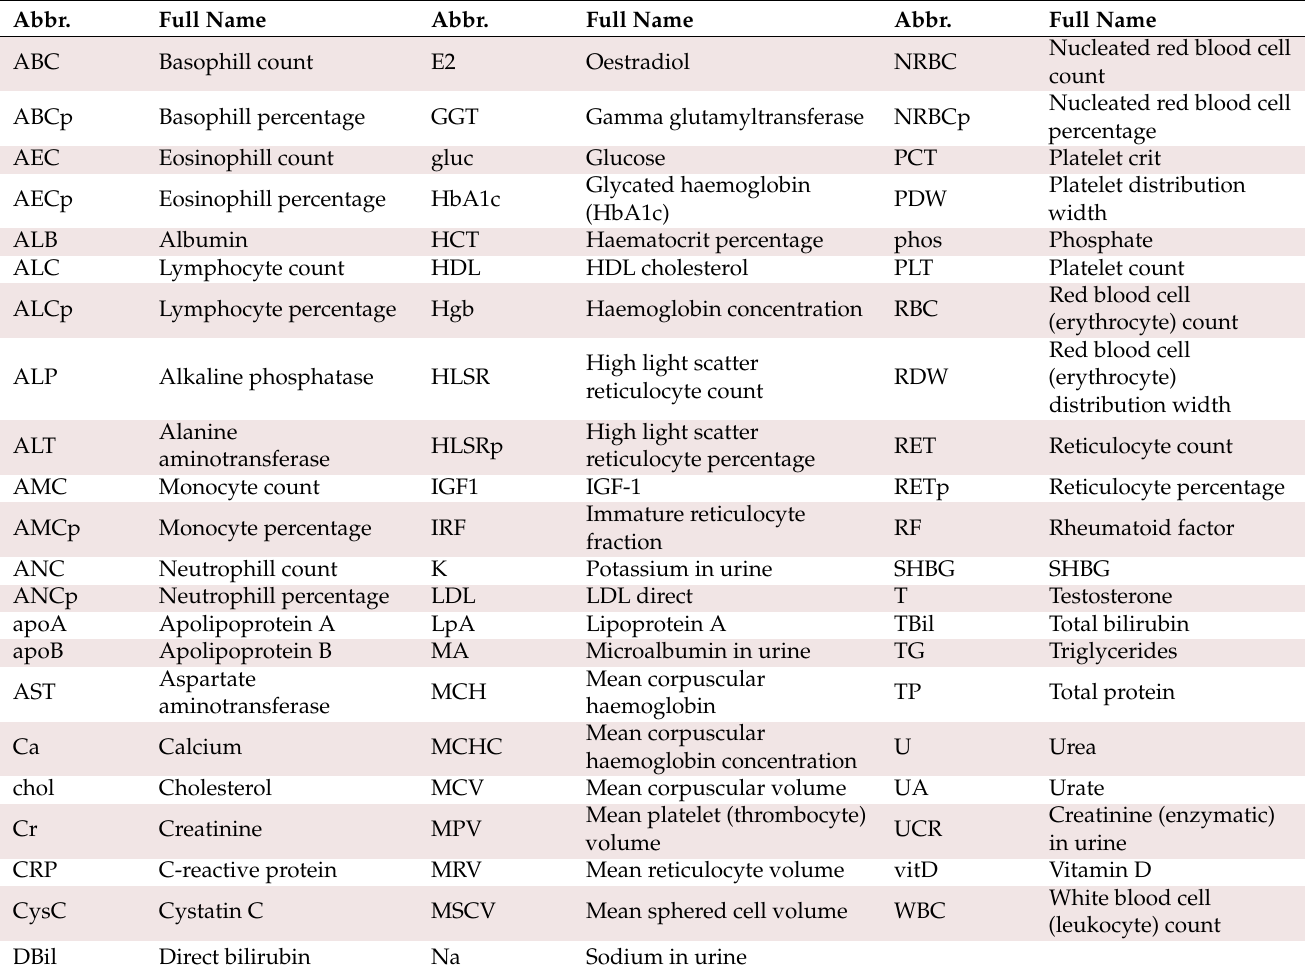
Table 1. List of all studied blood and urine markers with